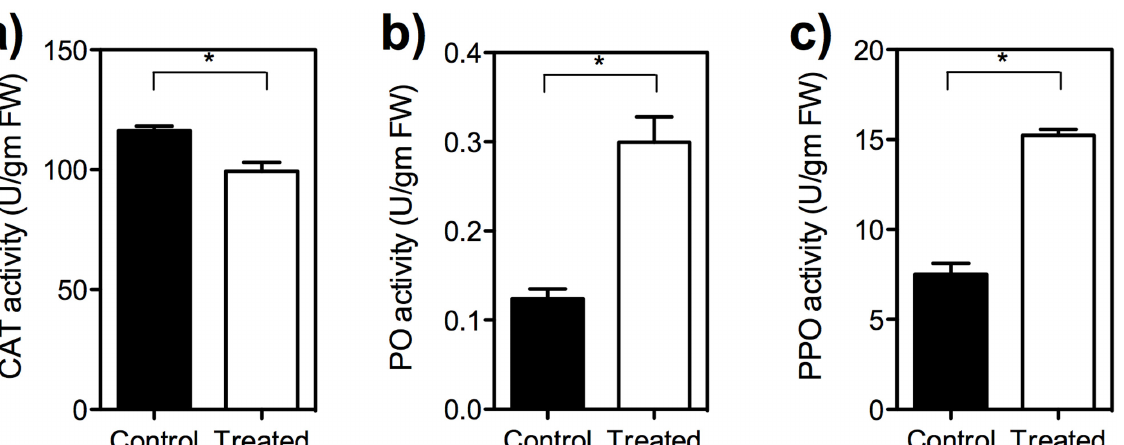
Fig 8. The effect of SA on the expression of antioxidative enzymes. (a) Catalase; (b) Peroxidase and (c) Polyphenoloxidase activity. The results showed inhibition of catalase activity and an increase of peroxidase and polyphenoloxidase activities in the treated fruit (unpaired t test, t = 4.01, df = 4, P =